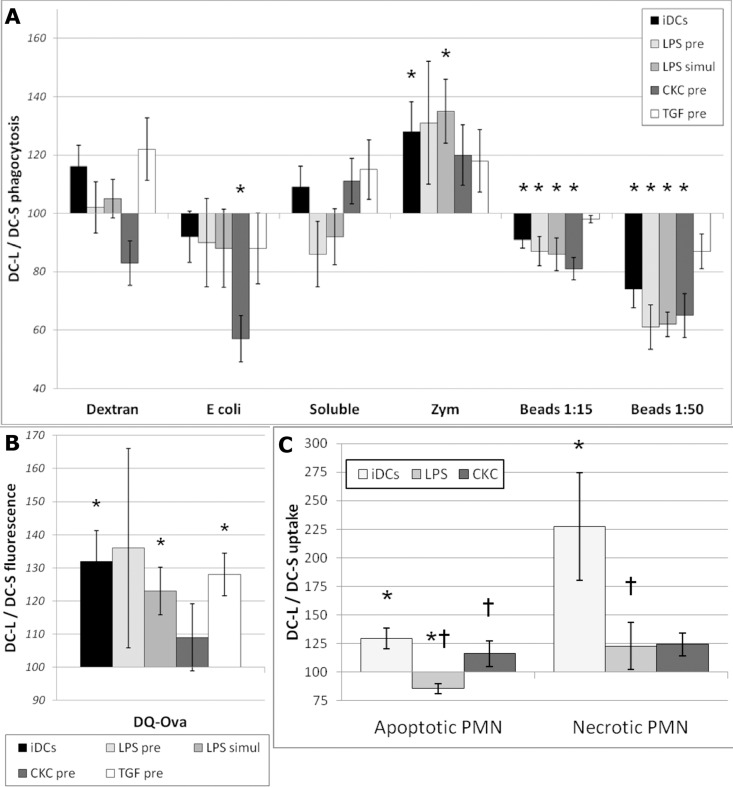
Phagocytosis, antigen-processing, and uptake of dying cells by DC-S vs DC-L.A) Targets were added to iDCs, to DCs previously stimulated for 24 hrs with LPS, CKC, or TGF-β (“pre”), or simultaneously with LPS (“simul”), as indicated. * = p < 0.05 for the DC-L / DC-S MFI ratio. n≥3. Only SB- or PI-negative cells shown. Error bars = ±SEM. DCs were incubated with the indicated fluorescent targets for 8–12 hours and then analyzed by flow cytometry. B) Same as "A" but using DQ-ovalbumin, which is ovalbumin over-conjugated with fluorochrome, and thus self-quenching. After uptake and degradation, the fluorochromes in the resulting peptides are sparser and can fluoresce; therefore, higher fluorescence indicates higher uptake and/or processing of the original protein. C) DCs were incubated with DiD-labeled (fluorescent) apoptotic PMN at a ratio of 1:4 for 8–12 hours. Apoptotic cells were added to iDCs or to DCs previously stimulated for 24 hours with LPS or CKC, as indicated. Samples were then stained with HLA-DR or DCSIGN to specifically identify the DCs, and analyzed by flow cytometry. The MFI of DC-S was normalized to 100; values above and below 100 indicate higher and lower expression, respectively, among DC-L as compared to DC-S. * = p < 0.05 for the DC-L / DC-S MFI ratio. † = p < 0.05 for the DC-L / DC-S MFI ratio change in mature vs immature DCs (paired t-test). n ≥ 3. Only SB- or PI-negative cells shown. Error bars = ±SEM.